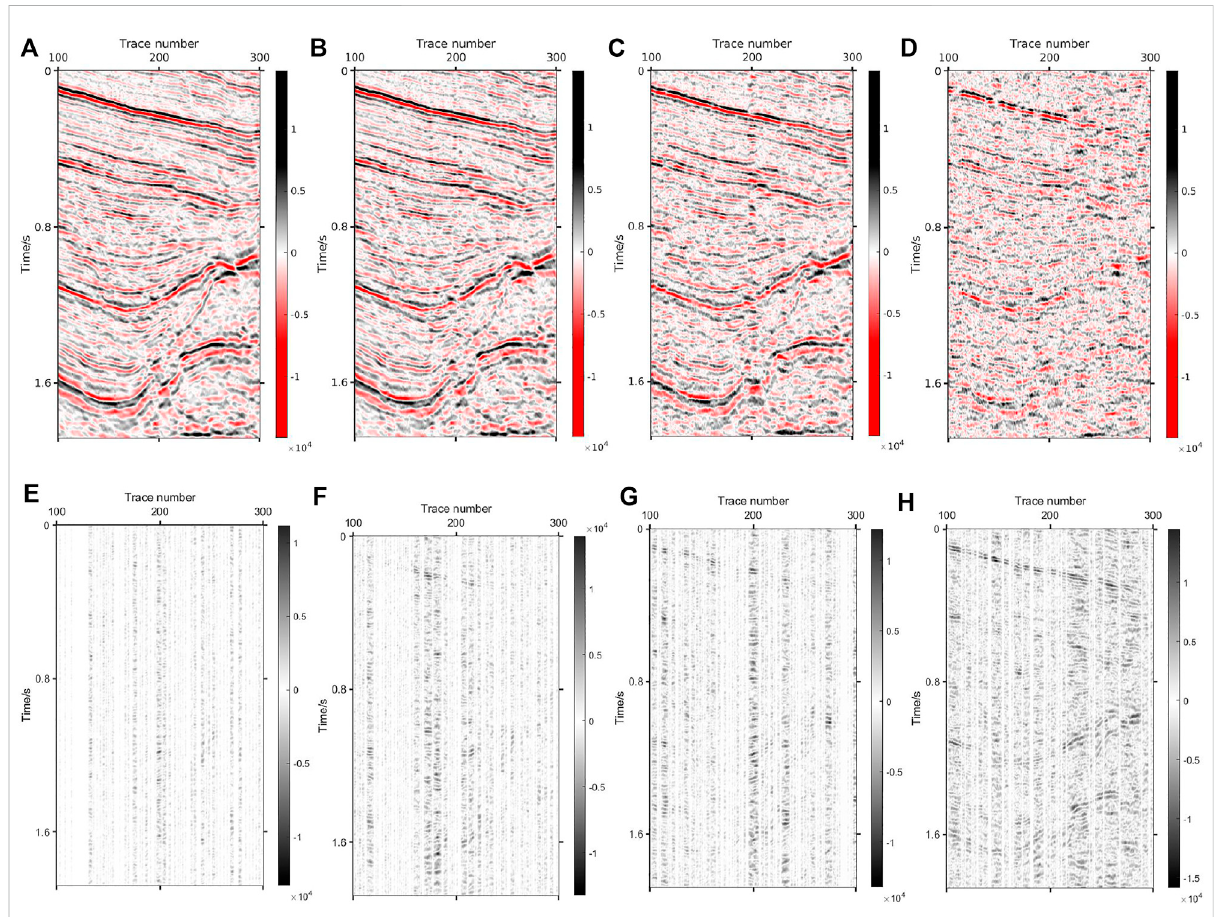
FIGURE 13 Curvelat+DCT results via missing in different proportions. (A) Reconstructed result via 20% missing (SNR=15.32dBdB PSNR=31.67 dB). (B) Reconstructed result via 40% missing (SNR=8.87 dB PSNR=25.21 dB). (C) Reconstructed result via 60% missing (SNR=4.52 dB PSNR=20.87 dB). (D) Reconstructed result via 80% missing (SNR=0.36 dB PSNR=16.71 dB). (E) Absolute error via 20% missing; (F) Absolute error via 40% missing. (G) Absolute error via 60% missing; (H) Absolute error via 80%